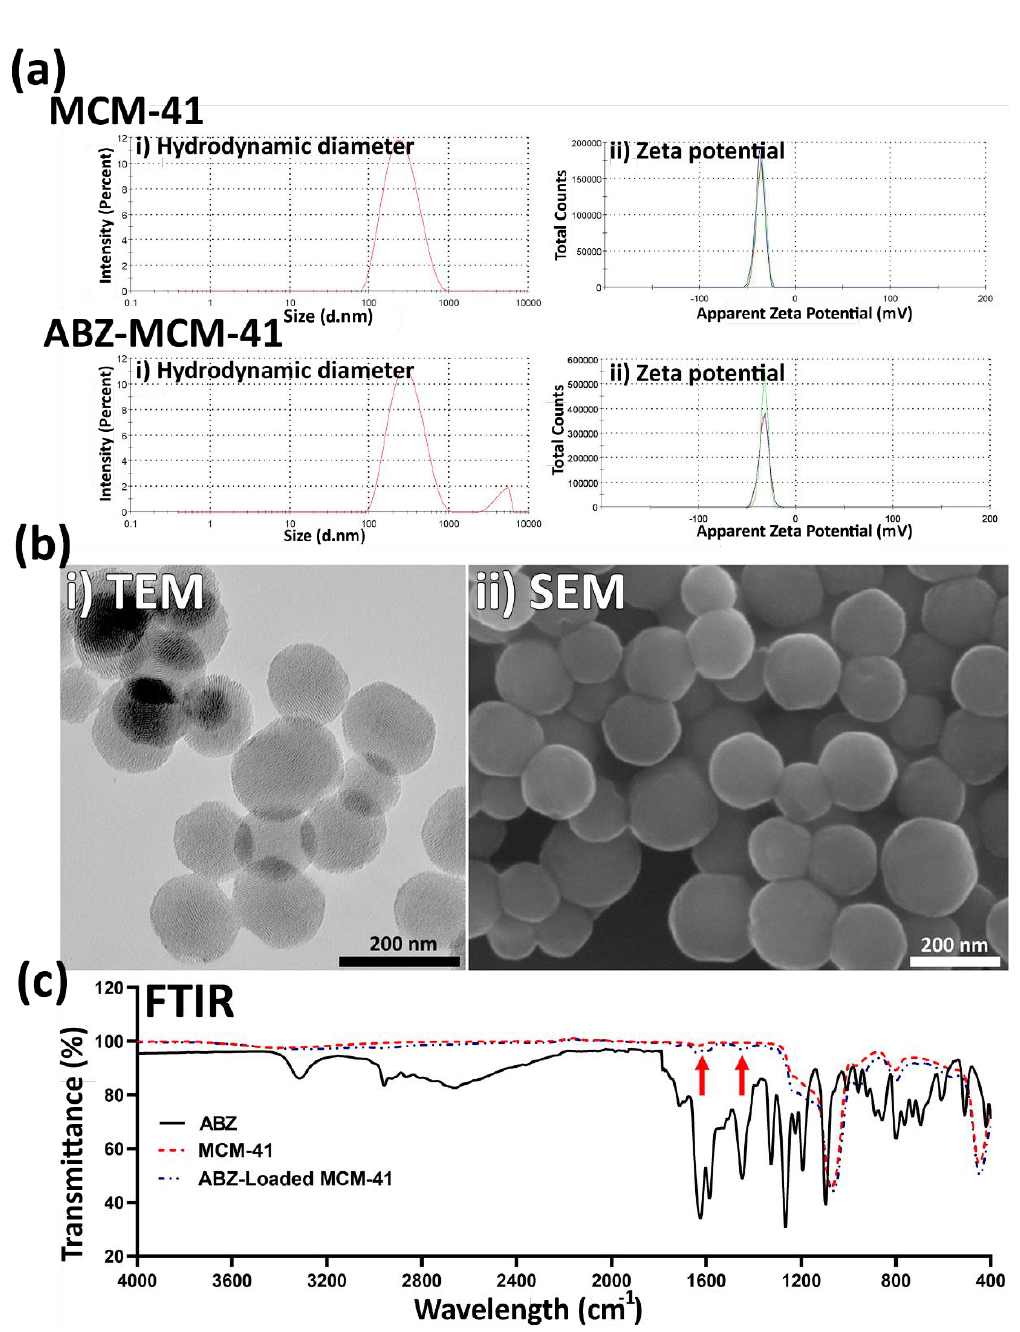
Figure 2: ( a) i) Hydrodynamic diameter and ii) zeta potential of Mobil Composition of Matter No. 41 (MCM-41) and albendazole (ABZ)-loaded MCM-41 NPs, measured by the dynamic light scattering (DLS) method. As the results demonstrated, both NP formulations were formed at the nanoscale size (220 ± 11.5 and 293 ± 8.7 nm for MCM-41 and ABZ-loaded MCM-41 NPs, respectively). Also, as the Figure shows, both NPs had negative zeta potential equal to -36.3 ± 4.57 and -33.0 ± 4.93 mV, respec- tively. ( b) i) Transmission electron microscopy (TEM) and ii) scanning electron microscopy (SEM) of ABZ-loaded MCM-41 NPs. As the TEM image demonstrates, mesoporous NPs with a hexagonal array of channels were formed. Also, the SEM image demonstrates that ABZ-loaded MCM-41 NPs were syn- thesized as homogeneous spheres without any discernible aggregation (×100,000 mag). (c) Fourier- transform infrared spectroscopy (FTIR) spectra of ABZ, MCM-41, and ABZ-loaded MCM-41 NPs. The peaks related to pure ABZ (e.g., 1623 cm −1 , demonstrated by arrows) were observed in the spectrum of ABZ-loaded MCM-41 NPs, confirming that ABZ was loaded into the NPs. Also, as the ABZ-related peaks remained intact in ABZ-loaded MCM-41 NPs, it could be concluded that the drug was loaded into these NPs